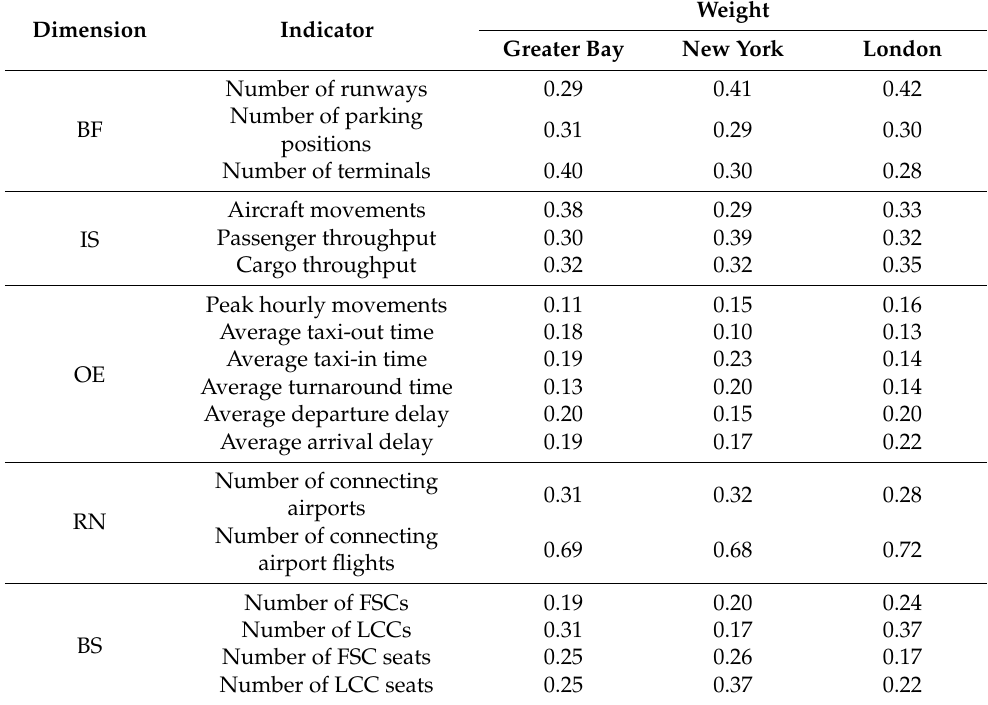
Table 1. Indicator weight of first